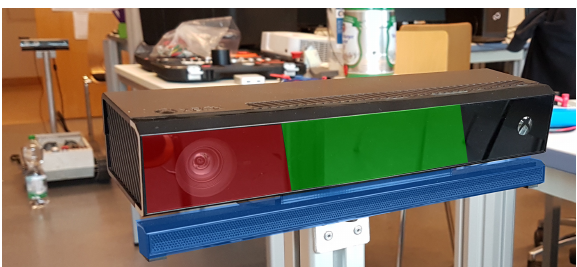
Figure 2. Overview of the Kinect